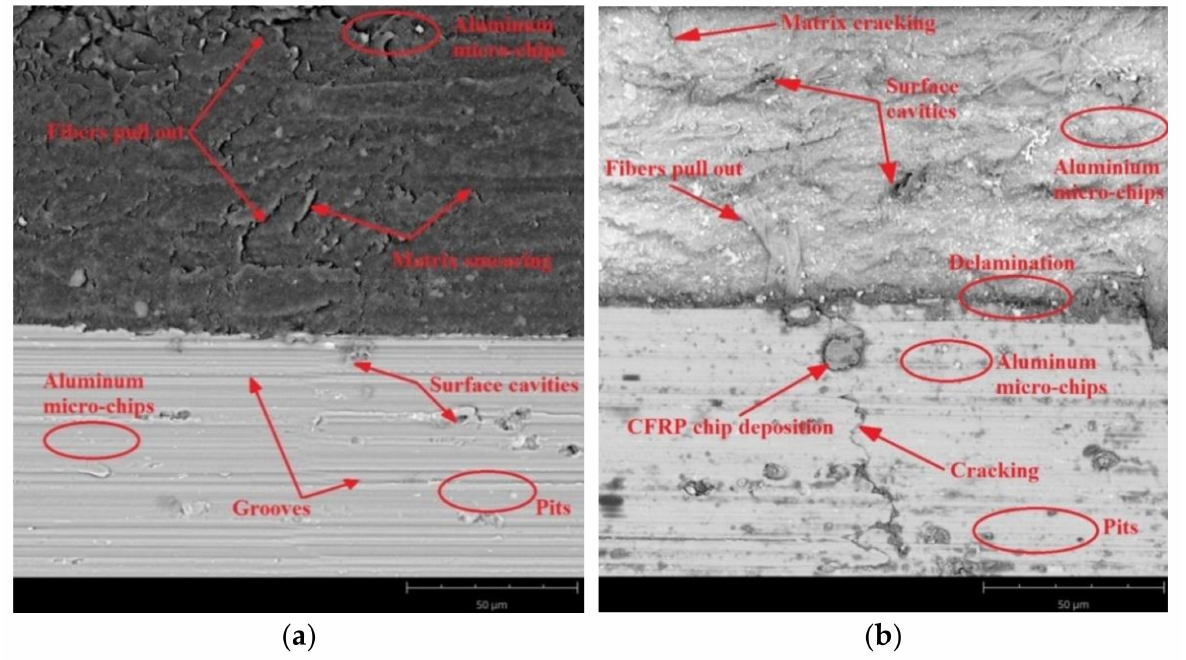
Figure 11. SEM images of aluminium alloy and CFRP surfaces after milling with a feed rate of f z = 0.04 mm/blade and strategy: ( a ) Al/CFRP, ( b ) CFRP/Al.